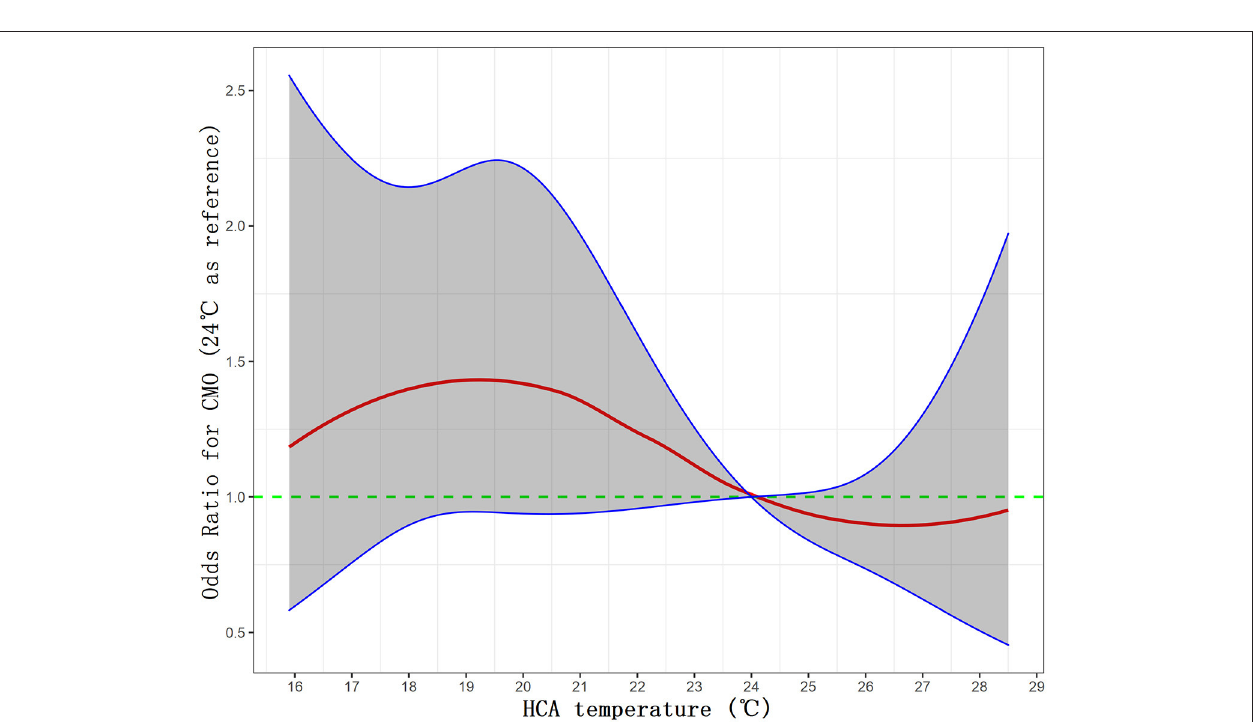
FIGURE 3 | Visualization of the relationship between HCA and CMO by restricted cubic splines to the logistic model. CMO, composite major outcomes; HCA, hypothermic cardiac arrest.